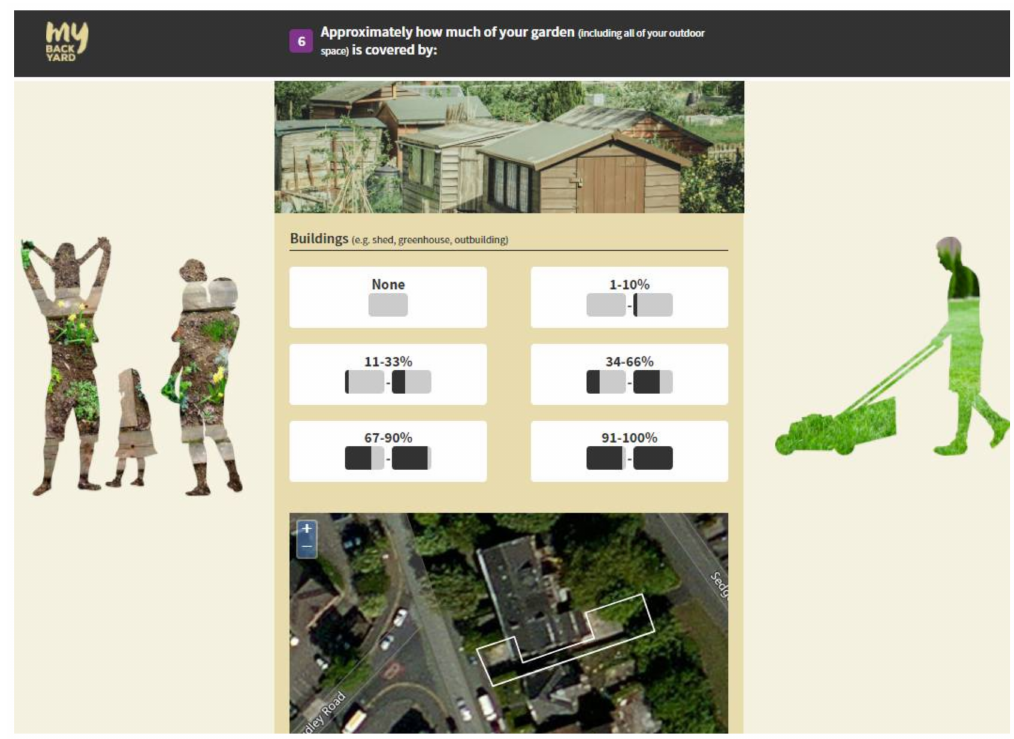
Figure 2. The My Back Yard online survey tool—an example question about the proportional surface cover for